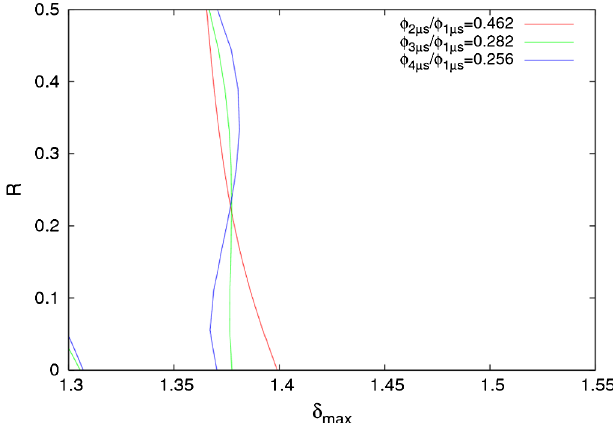
FIG. 6. Combinations of (cid:1) - R values characterizing the max chamber surface, obtained by benchmarking ratios of observed pressure increases against ratios of simulated electron fluxes, for ¼ measurements on 25 October 2011. In this case a value " max 260 eV has been assumed, as it gives a better fit to the data. This during the scrubbing. could be a sign of variation of " max